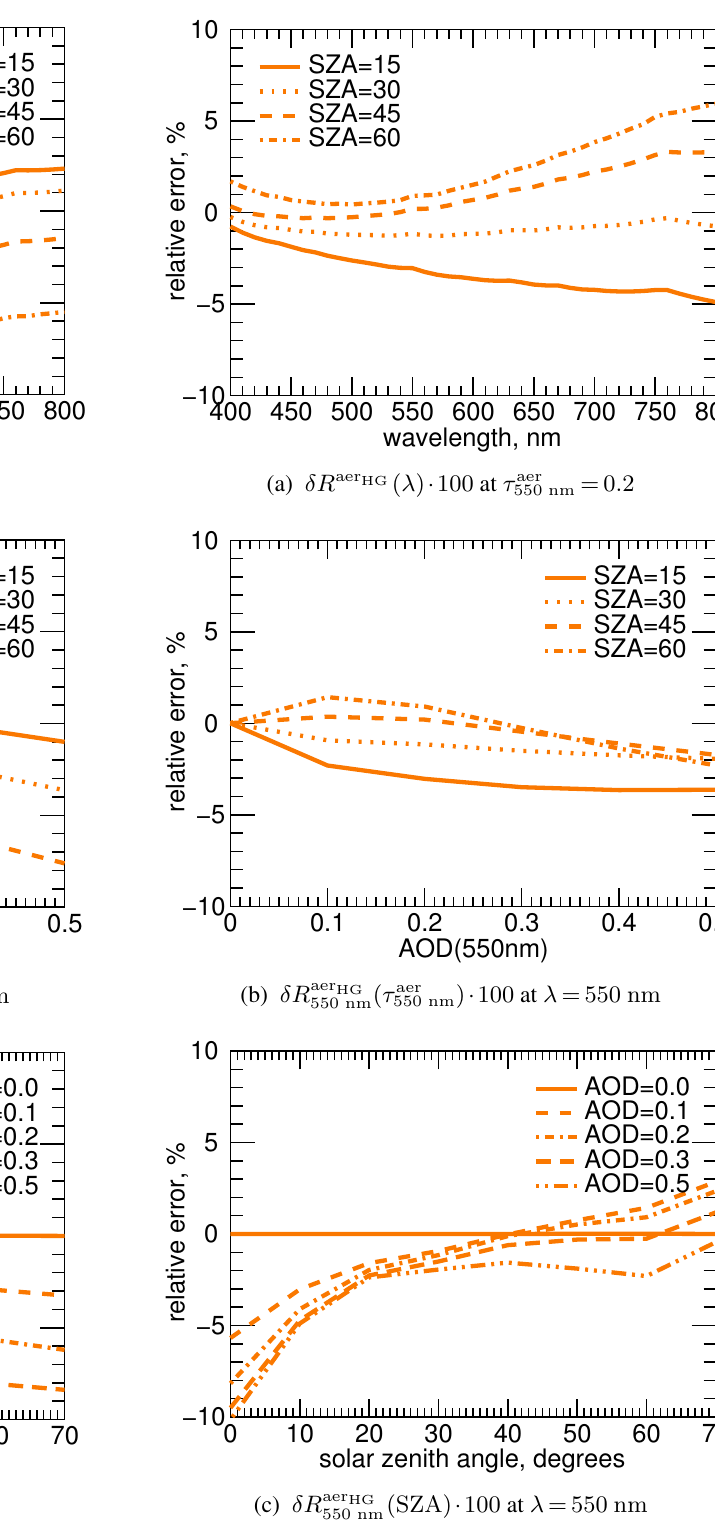
Fig. 5: . Percent error due to the non-coupling approximation with respect to wavelength, aerosol optical depth (AOD) and solar zenith angle (SZA) at top-of-atmosphere.